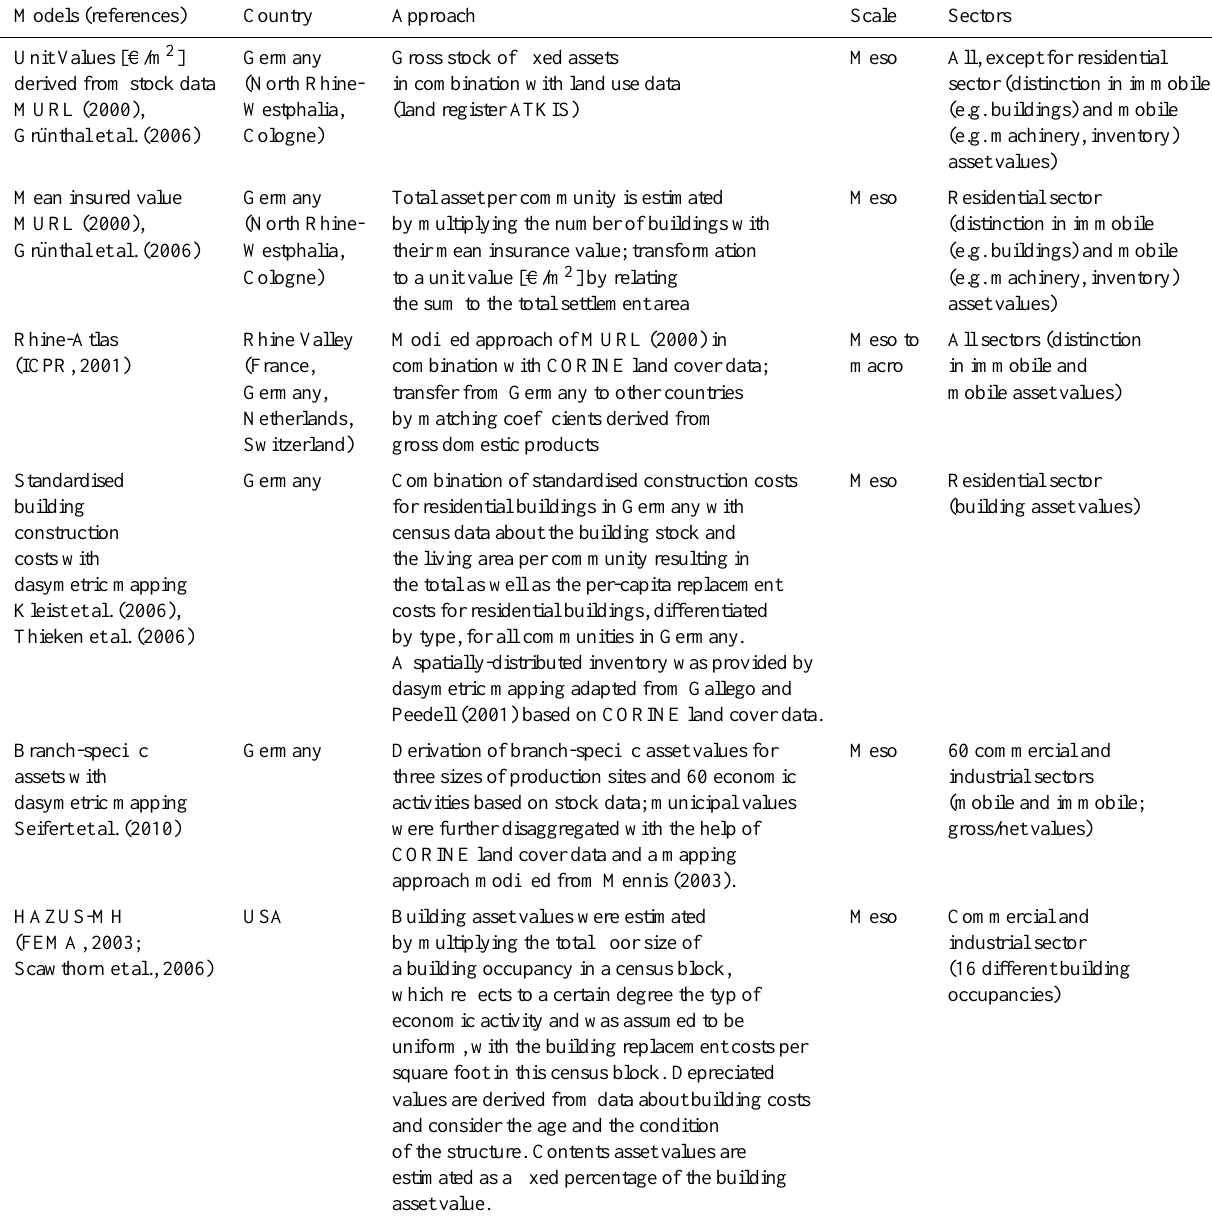
Table 2. Examples of approaches for the estimation of exposure data. (CORINE stands for Coordination of Information on the